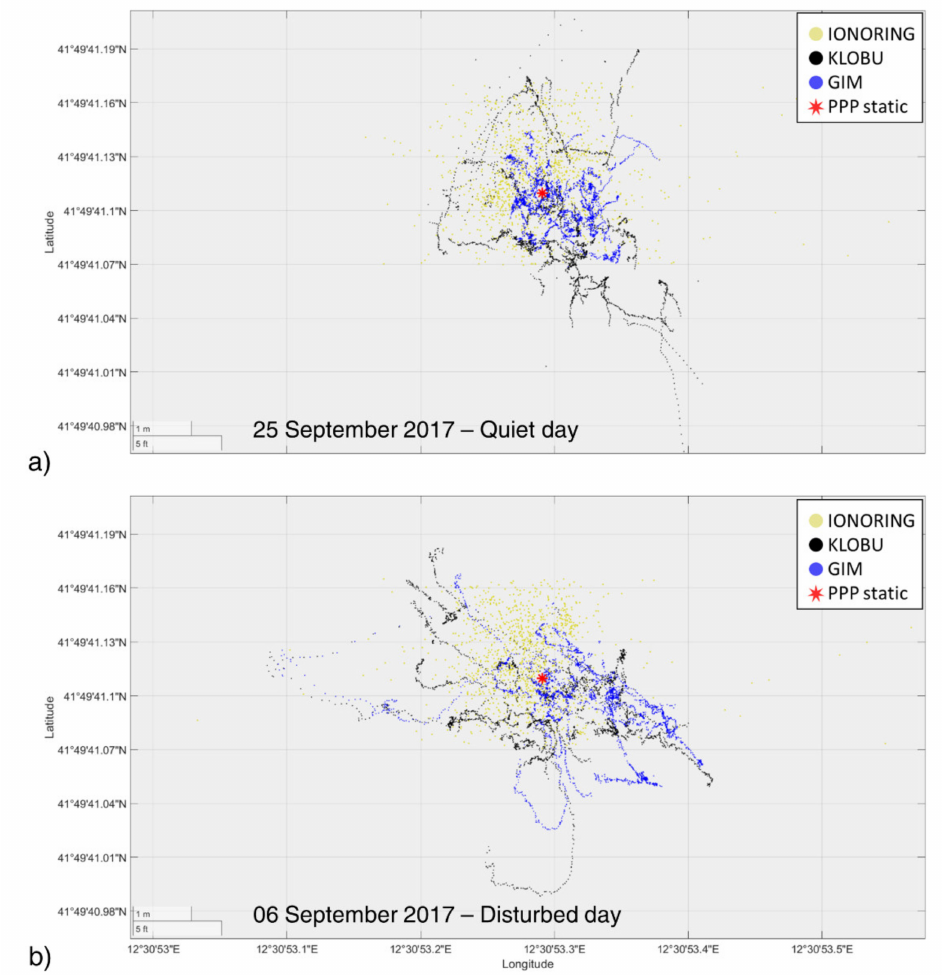
Figure 12. Single point positioning considering one quiet (25 September 2017, panel a ) and one disturbed (6 September 2017, panel b ) day of data from the ingr receiver realized by using different ionospheric information: IONORING TEC maps (pale yellow), Klobuchar model (black), and IGS GIMs (blue). The red star indicates the ground truth estimated with PPP in static